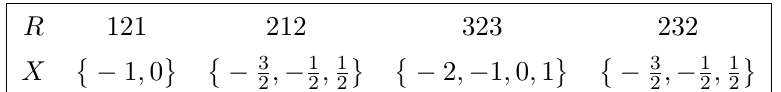
Table 3 . Possible hypercharges for each representation that could lead to a dark matter